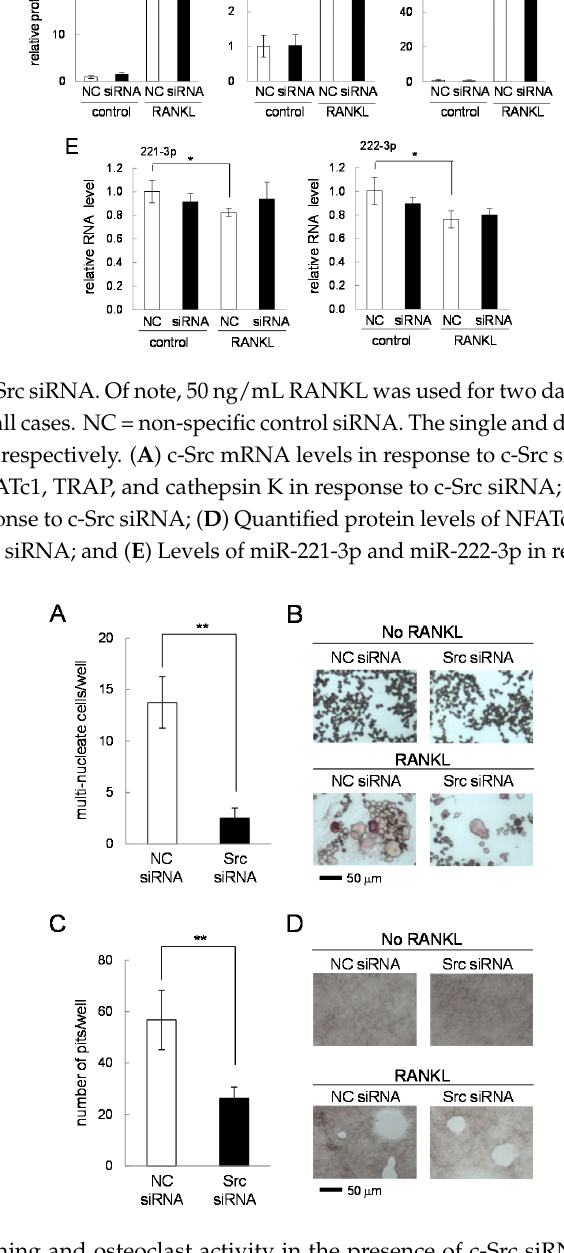
Figure 9. TRAP staining and osteoclast activity in the presence of c-Src siRNA. NC = non-specific control siRNA. The double asterisk indicates p < 0.01. ( A , B ) Number of multi-nucleated cells and TRAP staining in the presence and absence of 50 ng/mL RANKL for four days; and ( C , D ) Number of pits and their images in the presence and absence of 50 ng/mL RANKL for five days.